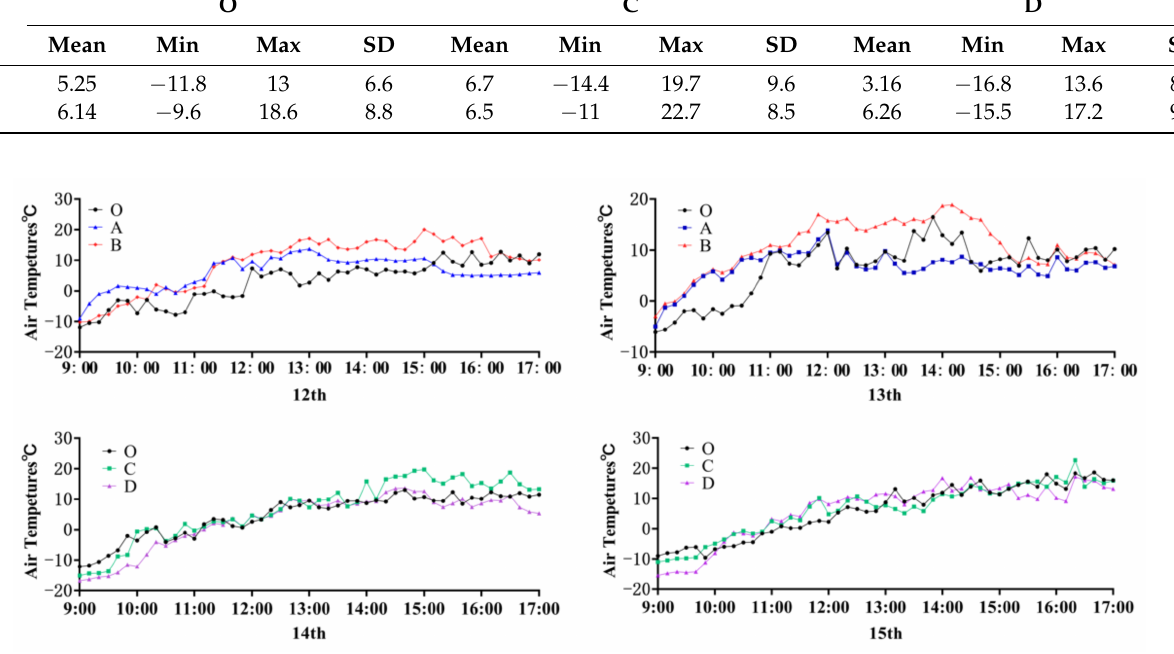
Figure 6. Comparison of air temperature changes in different